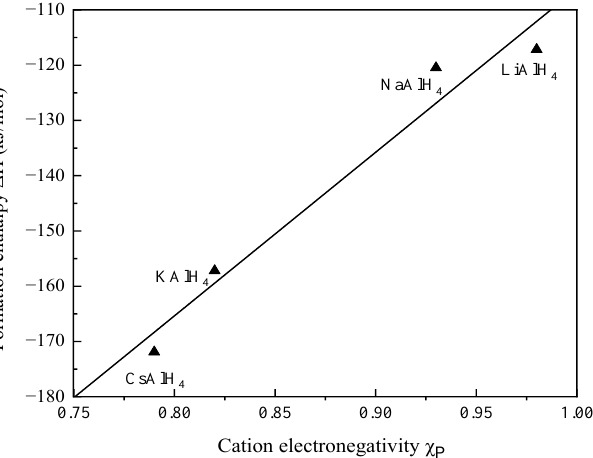
Figure 2. The formation enthalpy ( ∆ H) as a function of cation electronegativity ( χ P ) for MAlH 4 (M = Li, Na, K, and Cs) alanates. The straight line, ∆ H = 296.033 χ P − 402.19, indicates least square fitting.